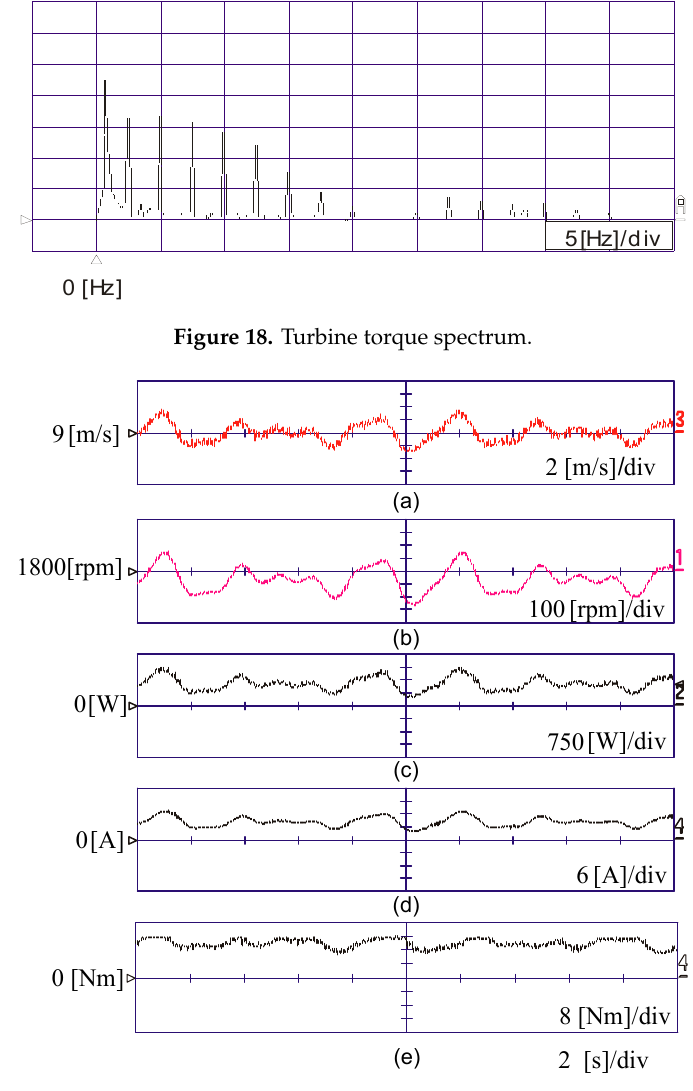
Figure 19. Turbulent wind speed: ( a ) Wind speed, ( b ) generator speed, ( c ) generator power, ( d ) q-axis current, and ( e ) and generator torque.